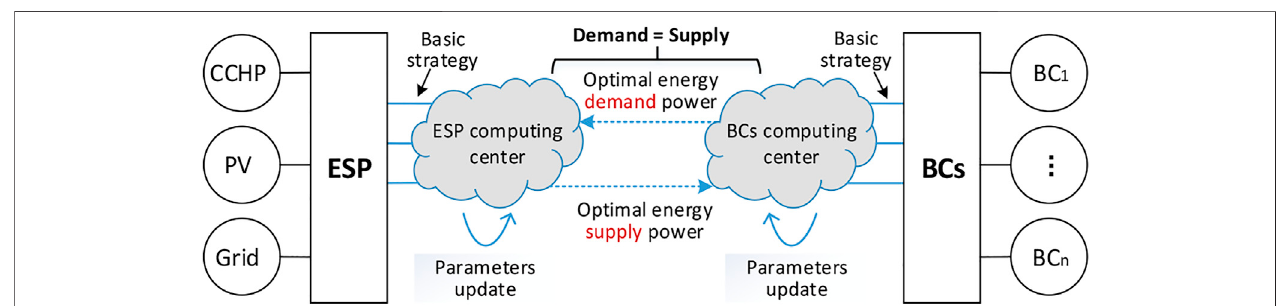
FIGURE 4 | Mechanism of ESP and BCs energy management